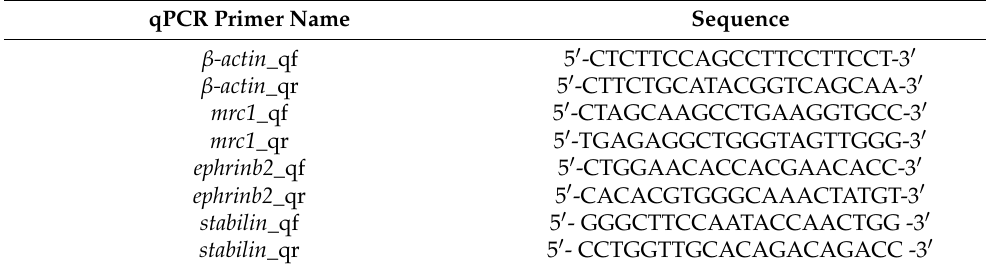
Table 1. Quantitative PCR (qPCR) primer sequences used in this study. qPCR Primer